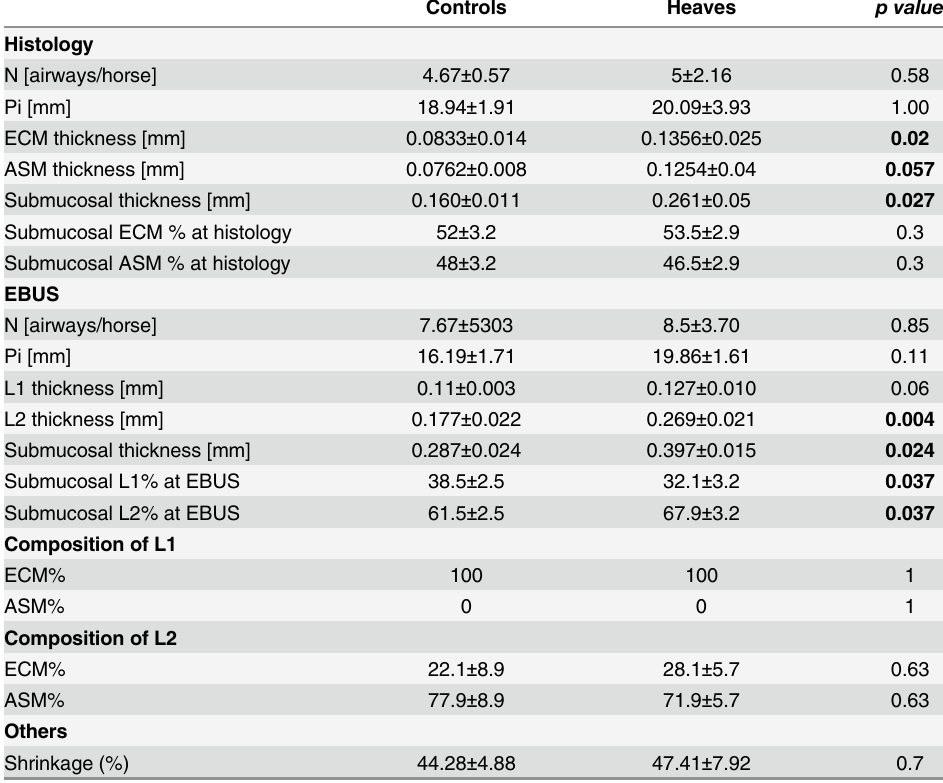
Controls Heaves p value